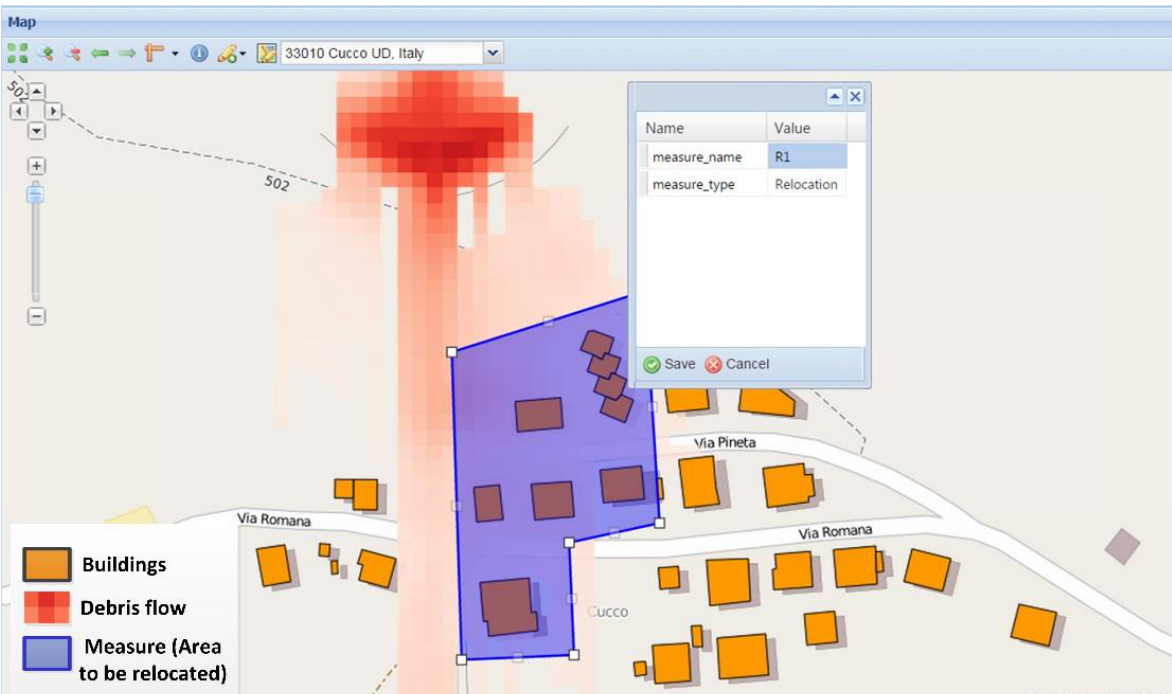
Figure 11. Sketching of a new measure (e.g., relocation) in the alternative